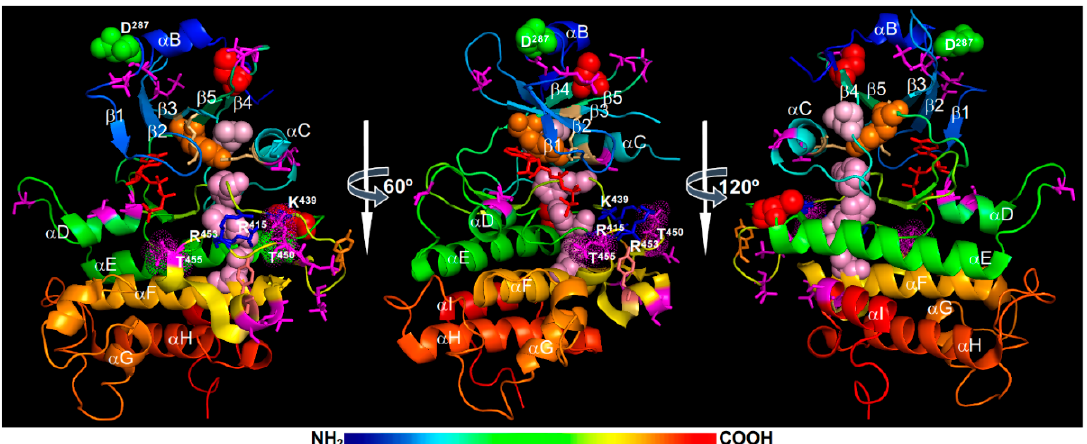
Figure 4. A crystal structure of the BAK1 kinase domain. Shown here are three rotation (0°, 60°, and 180°) views of a rainbow-colored ribbon model of the crystal structure of the BAK1 kinase domain (Protein Data Bank No: 3uim). Individual α -helices ( α B- α I) and β -strands ( β 1- β 5) were labelled. The purple sticks indicate phosphorylated Ser/Thr residues with the Thr 450 and Thr 455 residues surrounded with purple dots. The red sticks show the bound adenylyl-imidodiphosphate (a non-hydrolysable ATP analog), the light-orange sticks denote the two residues that form the conserved salt bridge between the β 3-strand and the α C-helix, the blue sticks represent the three positively charged residues that make up the phosphate-binding pocket, and the dark-orange sticks indicate phosphorylated Tyr residues. The pink spheres mark the R-spine residues, the red spheres show the two Cys residues that were S-glutathionylated in vitro, the orange spheres denote the gatekeeper Tyr residue, and the green spheres designate the Asp 287 residue important for Ca 2+ -dependent BAK1 cleavage. The rainbow bar indicates the order of AAs from the N-terminus (blue) to the C-terminus (red).